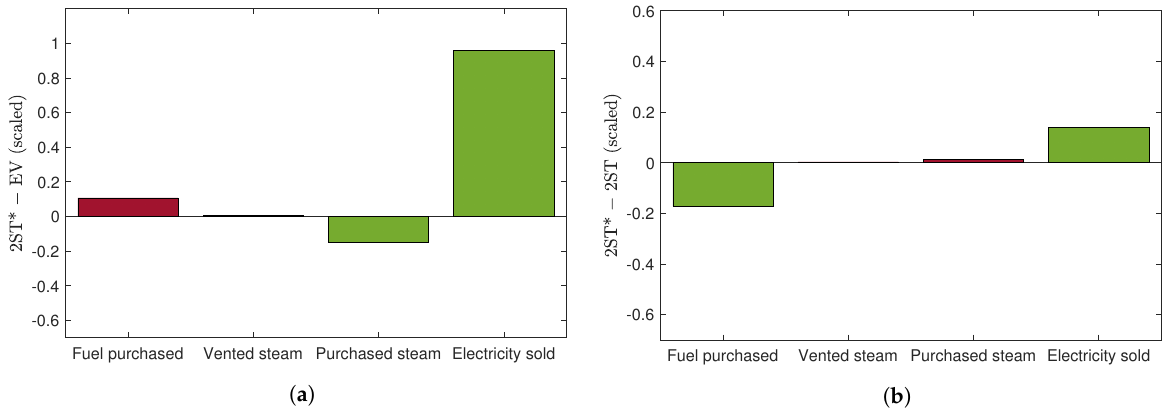
Figure 14. The comparison of the financial factors of the solutions. ( a ) The difference of the solutions 2ST ∗ and EV. ( b ) The difference of the solutions 2ST ∗ and